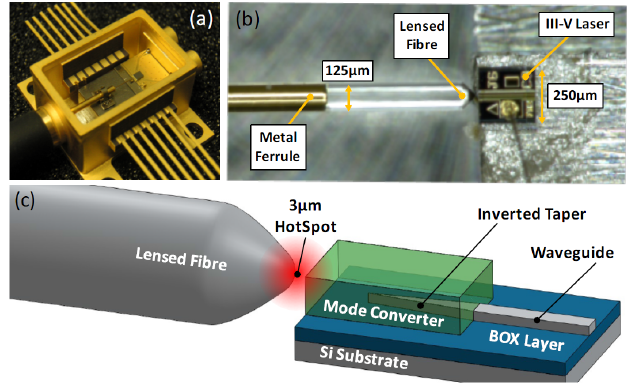
Figure 3. Fiber ‐ to ‐ PIC edge ‐ coupling; ( a ) Kovar ‘butterfly’ package for edge ‐ coupling. Kovar has the Figure 3. Fiber-to-PIC edge-coupling; ( a ) Kovar ‘butterfly’ package for edge-coupling. Kovar has the same thermal expansion coefficient as glass, so the Fiber ‐ to ‐ PIC alignment can be maintained, when same thermal expansion coefficient as glass, so the Fiber-to-PIC alignment can be maintained, when the ambient temperature changes; ( b ) Microscope image of an edge ‐ coupling to a III ‐ V laser ‐ chip the ambient temperature changes; ( b ) Microscope image of an edge-coupling to a III-V laser-chip using using a lensed fiber. The fiber is mounted into a metal ferule, so it can be laser ‐ welded to the kovar a lensed fiber. The fiber is mounted into a metal ferule, so it can be laser-welded to the kovar butterfly butterfly package; ( c ) Schematic of edge ‐ coupling to a Si ‐ PIC using a lensed ‐ fiber and spot ‐ size package; ( c ) Schematic of edge-coupling to a Si-PIC using a lensed-fiber and spot-size converter (SSC), or converter (SSC), or mode ‐ converter (MC), to help bridge the gap between the mode ‐ size in the fiber mode-converter (MC), to help bridge the gap between the mode-size in the fiber and on-PIC and on ‐ PIC waveguide.